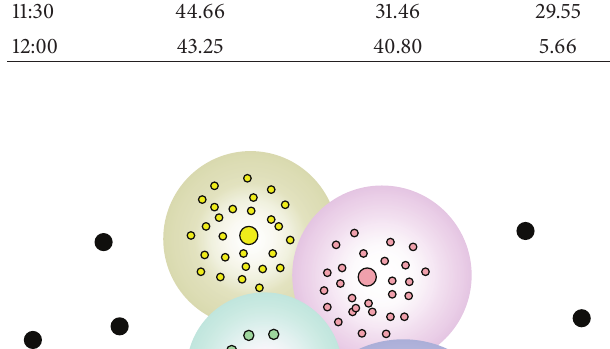
Definition 4 (cluster). Clusters are the nonempty subs of the data set 𝐷 that are density-connected from all core